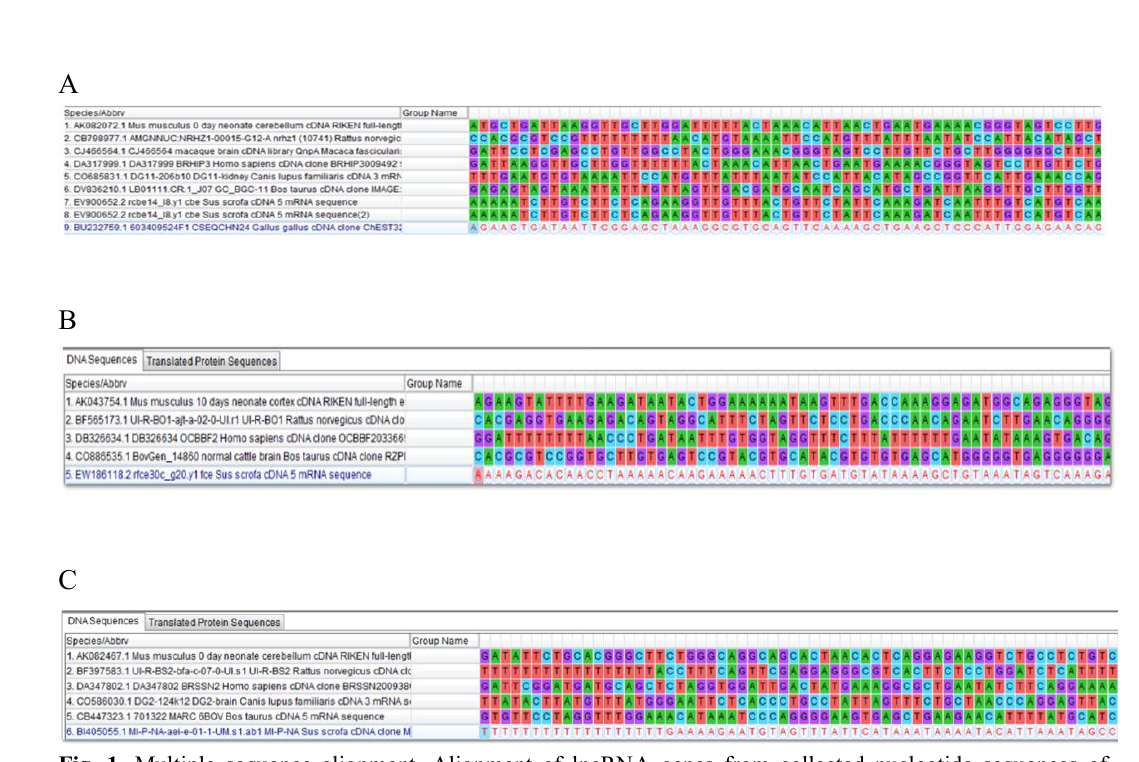
Fig. 1. Multiple sequence alignment. Alignment of lncRNA genes from collected nucleotide sequences of different species: (A) AK082072; (B) AK043754; (C)